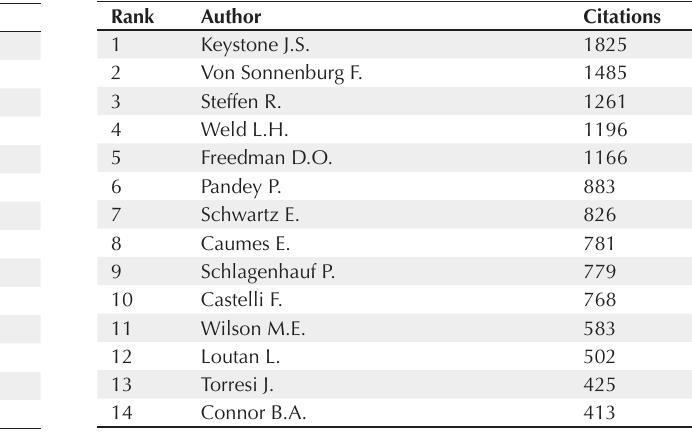
Table 4. Authors With Largest Cumulative Citation Records in the Top- Cited